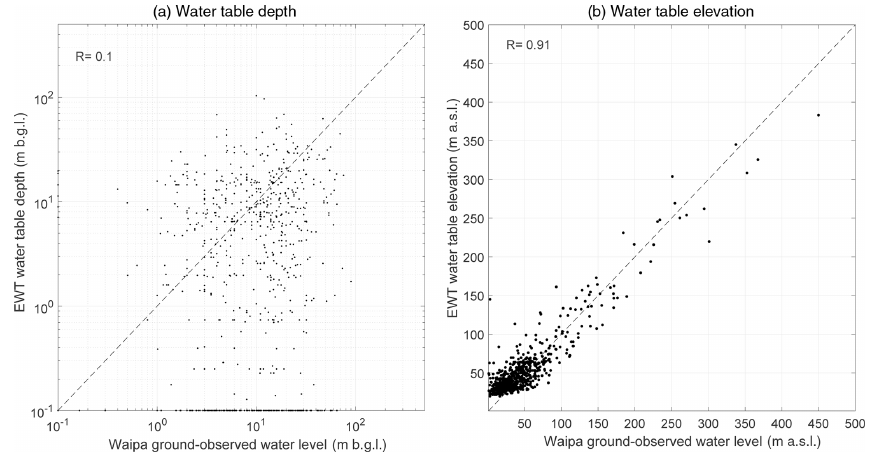
Figure 15. Correlation of EWT water table depth and water table elevation with ground observations in the Waipa River catchment. The dashed line is the 1 : 1 relation.